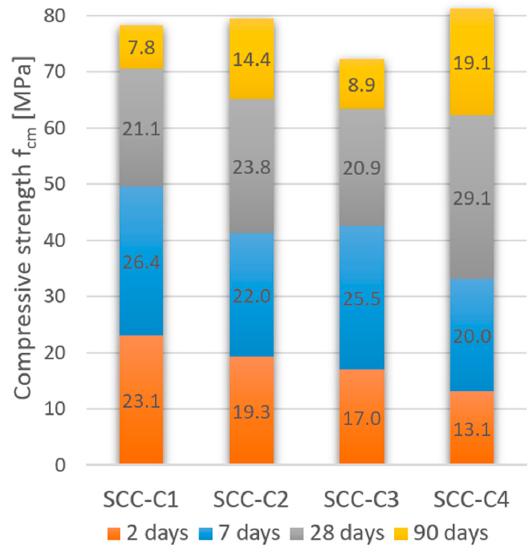
Figure 12. Compressive strength f cm —concretes SCC.